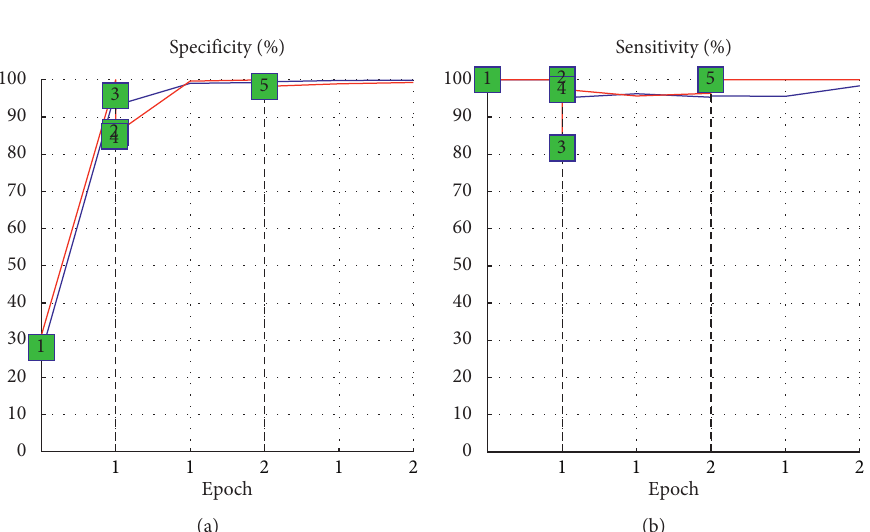
Figure 6: Results of the cross-patient seizure detection procedure in terms of Specificity (a) and Sensitivity (b), starting from the seizure detection model of patient #9 and fine-tuning it for patient #5. Figure shows the trend of Specificity and Sensitivity during the temporal occurrence of the 5 seizures of patient #5. Blue line: trend on the training set; red line: trend on the validation set; green squares: results on the test